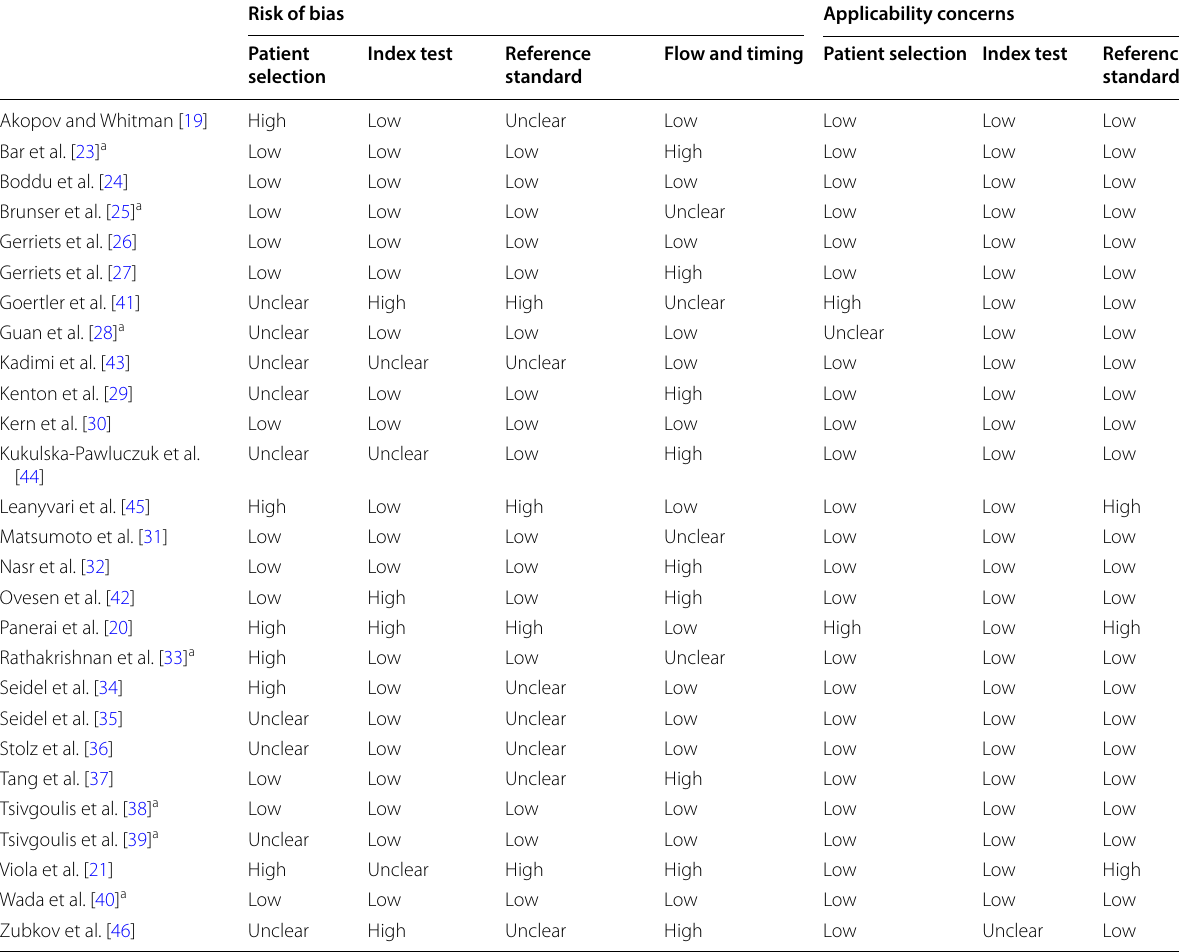
Table 3 Risk of bias and applicability concerns